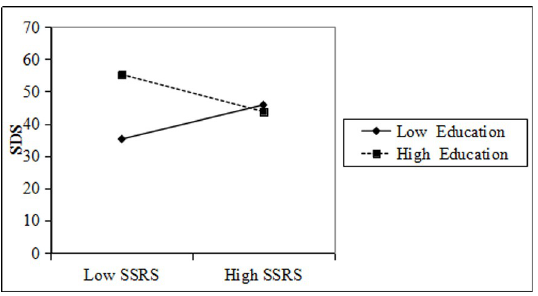
Fig 3. Education moderation interaction diagram for SSRS and physician